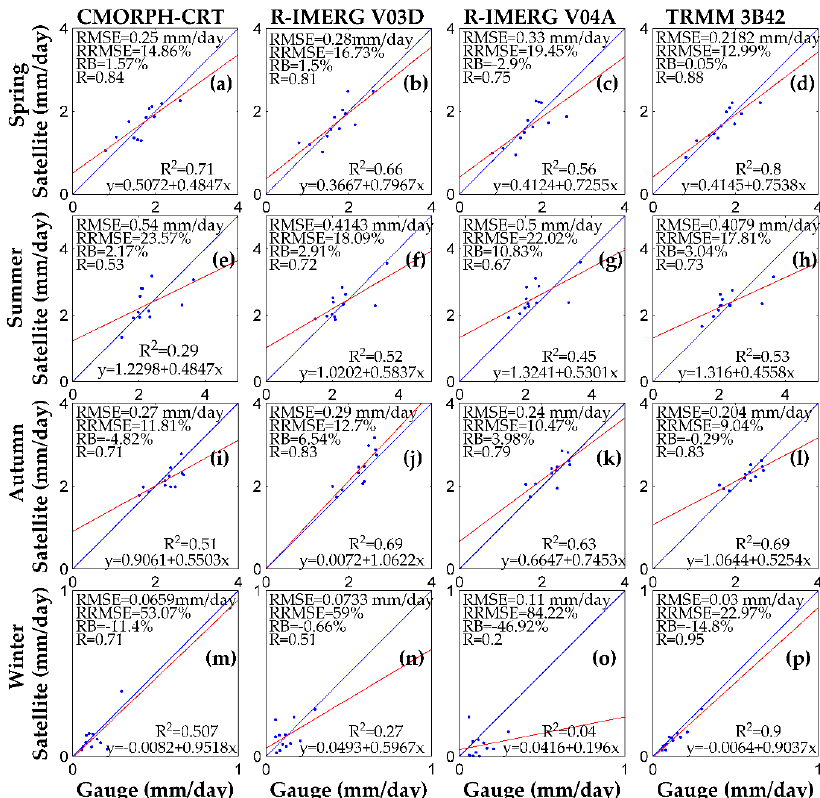
Figure 14. Scatterplots of satellite-based estimates versus rain gauge observations of average daily rainfall for different seasons over the Weihe River Basin for CMORPH-CRT ( a , e , i , m ), R-IMERG V03D ( b , f , j , n ), R-IMERG V04A ( c , g , k , o ), and TRMM 3B42 ( d , h , l , p ).